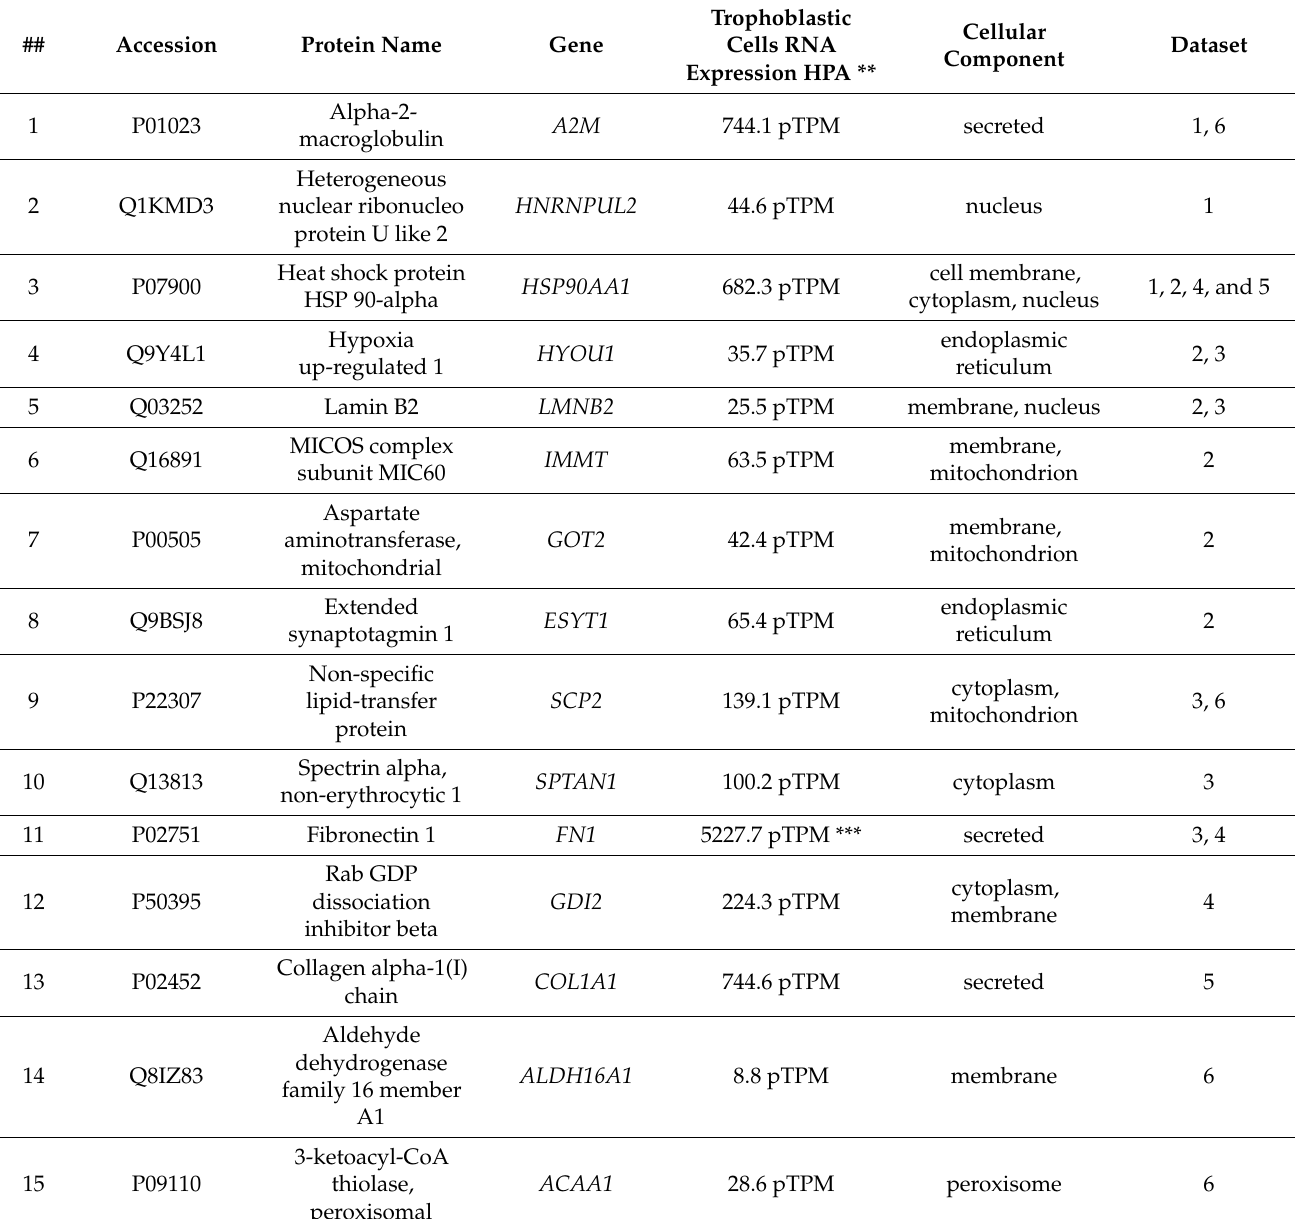
Table 3. The list of low-abundance proteins * that are reliably quantified in chorionic villi depends upon the tissue preparation procedure for MS/MS